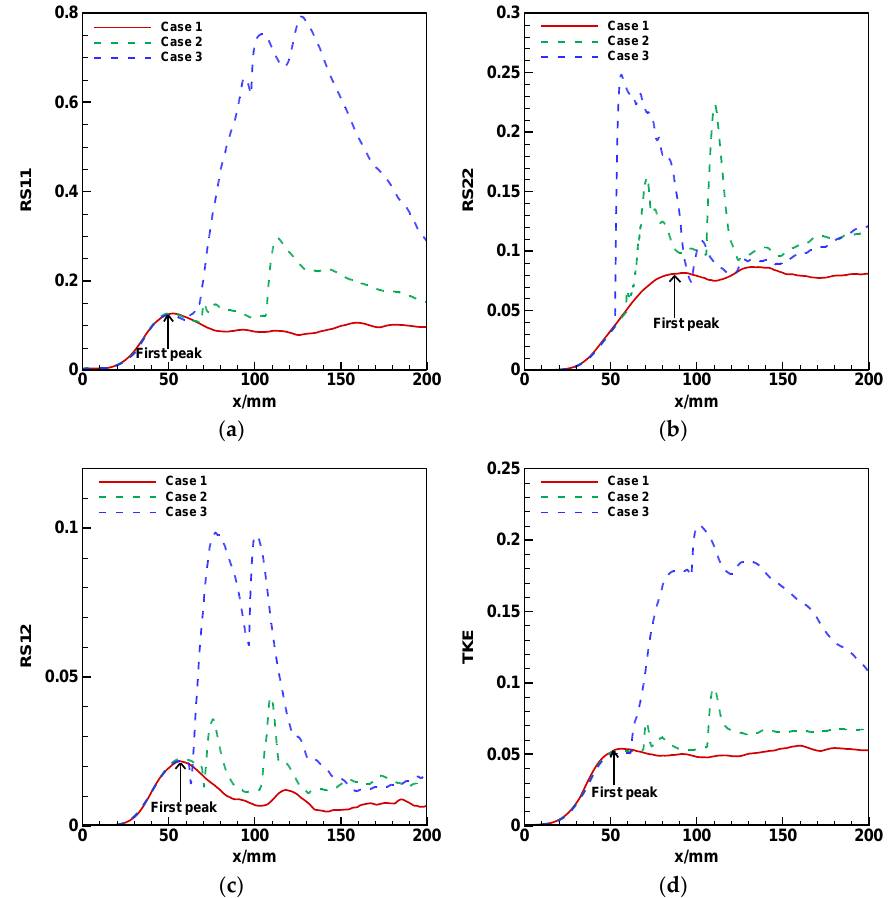
Figure 8. Peak value of turbulence intensity along streamwise direction for three cases: ( a ) 𝑅𝑆11 ; ( b ) 𝑅𝑆22 ; ( c ) 𝑅𝑆12 ; ( d ) 𝑇𝐾𝐸 .